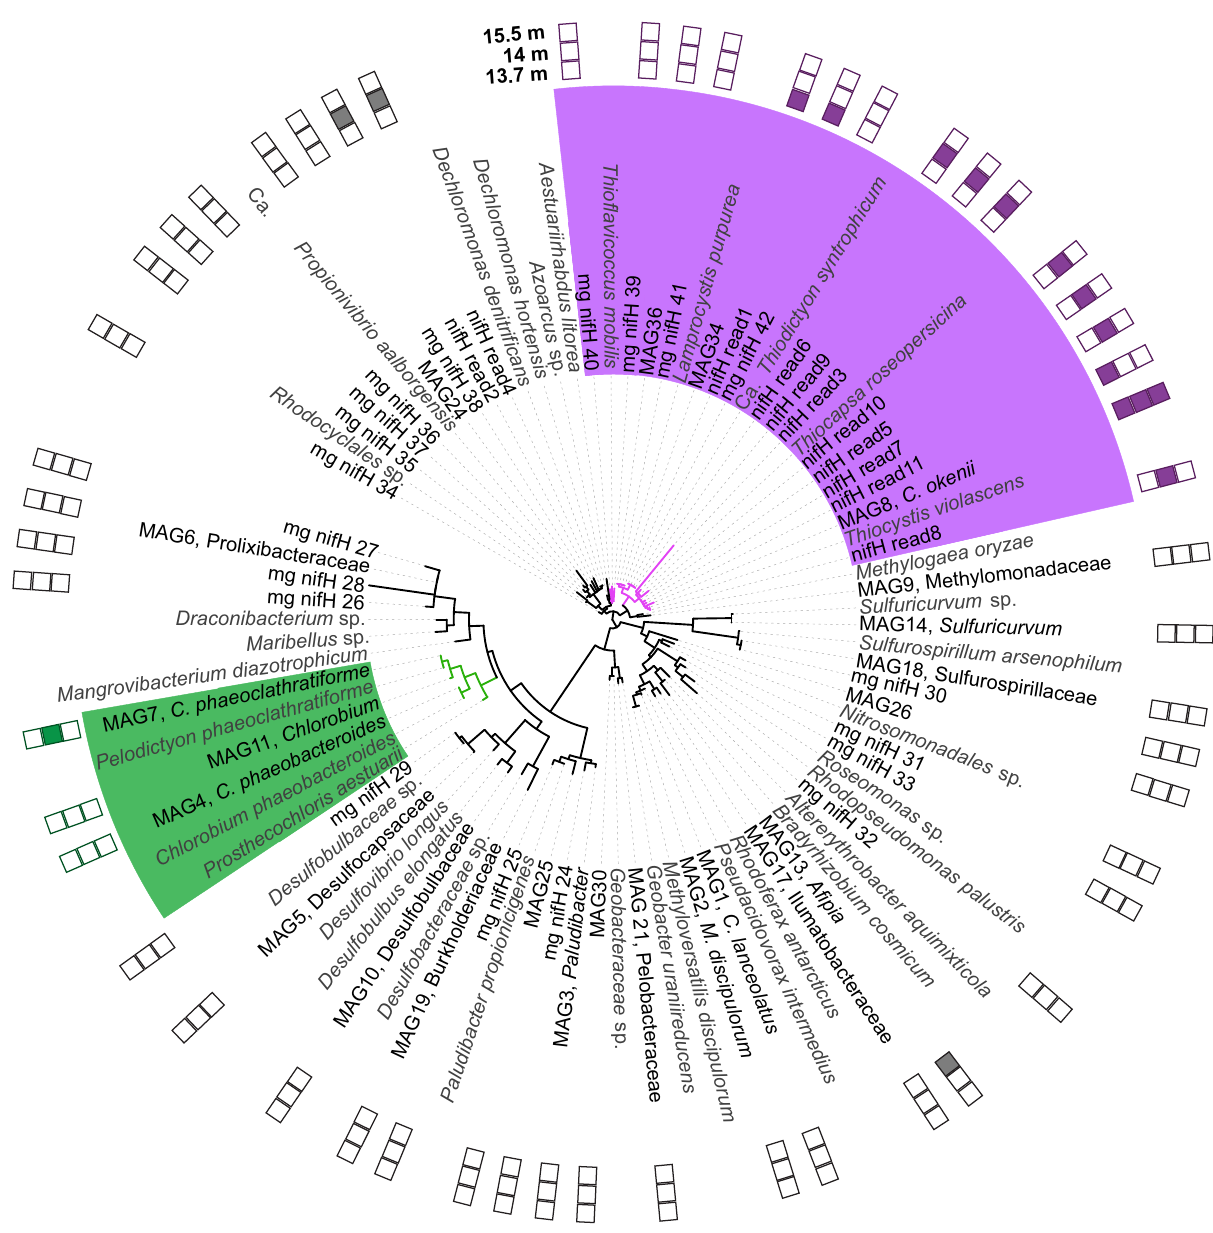
Fig. 2 NifH diversity in Lake Cadagno metagenomes and metatranscriptomes. Tree shows all veri fi ed NifH amino acid sequences obtained from the assembled metagenome from 2014 (MAG sequences and unbinned mg_nifH sequences) and the three metatranscriptomes from 2018 (nifH_read sequences). Reference sequences obtained from NCBI are indicated in gray. Transcription (presence) is indicated by fi lled boxes in 13.7 m, 14 m, and 15.5 m water depths from inner to outer circle, respectively, while empty boxes indicate that no transcription of the gene was detected. Detailed read counts are listed in Table S3. Sequences originating from GSB and PSB are highlighted in green and purple, respectively. MAG taxonomy was inferred from GTDB-Tk classi fi cation. The lowest taxonomic rank assigned is shown, with no taxonomic information indicating that classi fi cation based on GTDB-Tk was not possible due to a lack of suf fi cient marker genes (see also Fig.